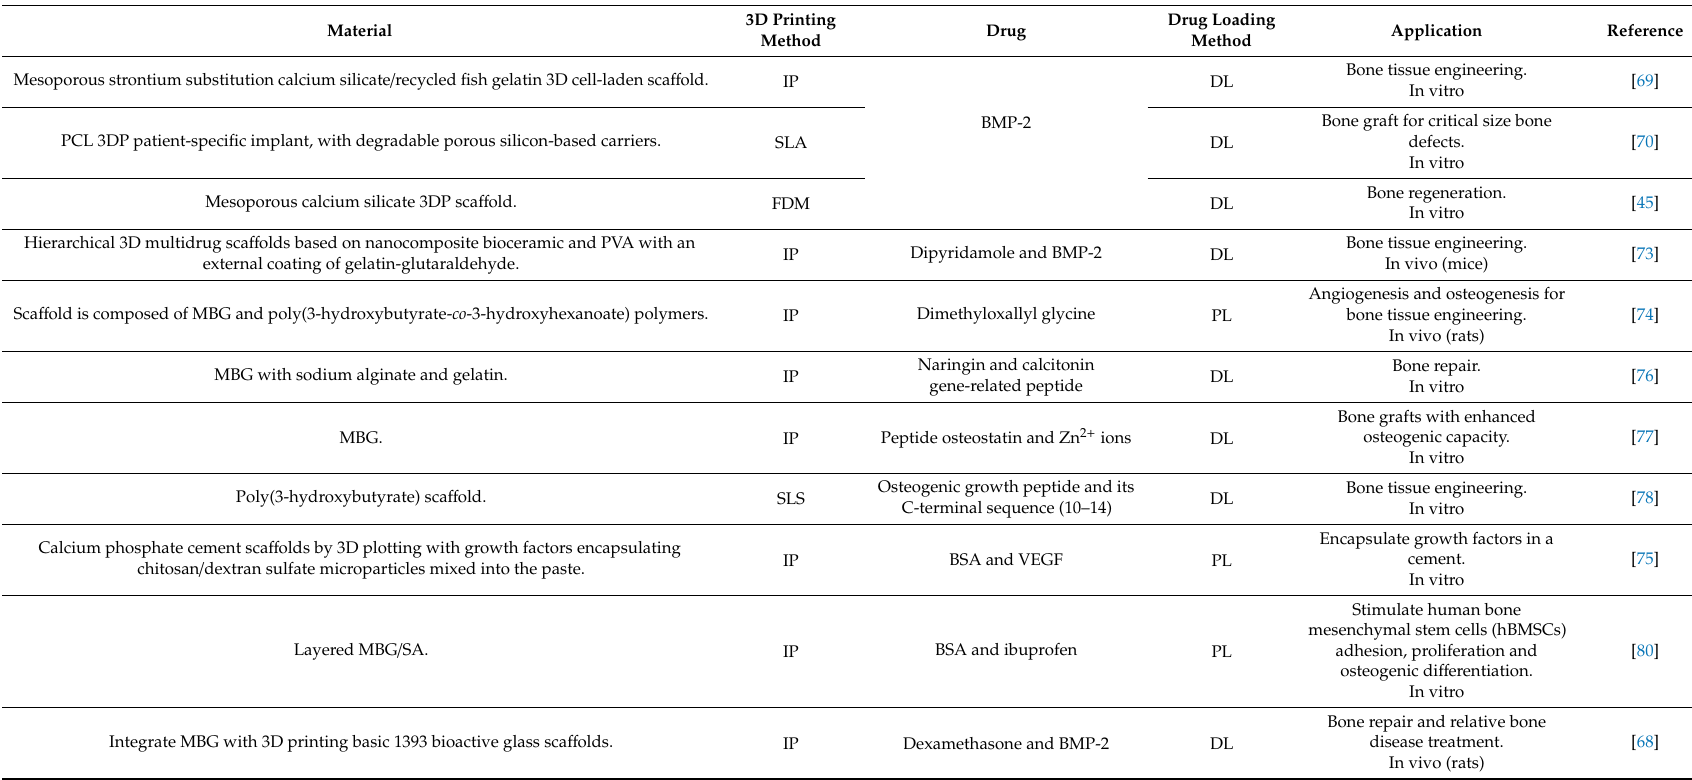
Table 1. Applications of 3DP porous materials for tissue engineering and bone substitute